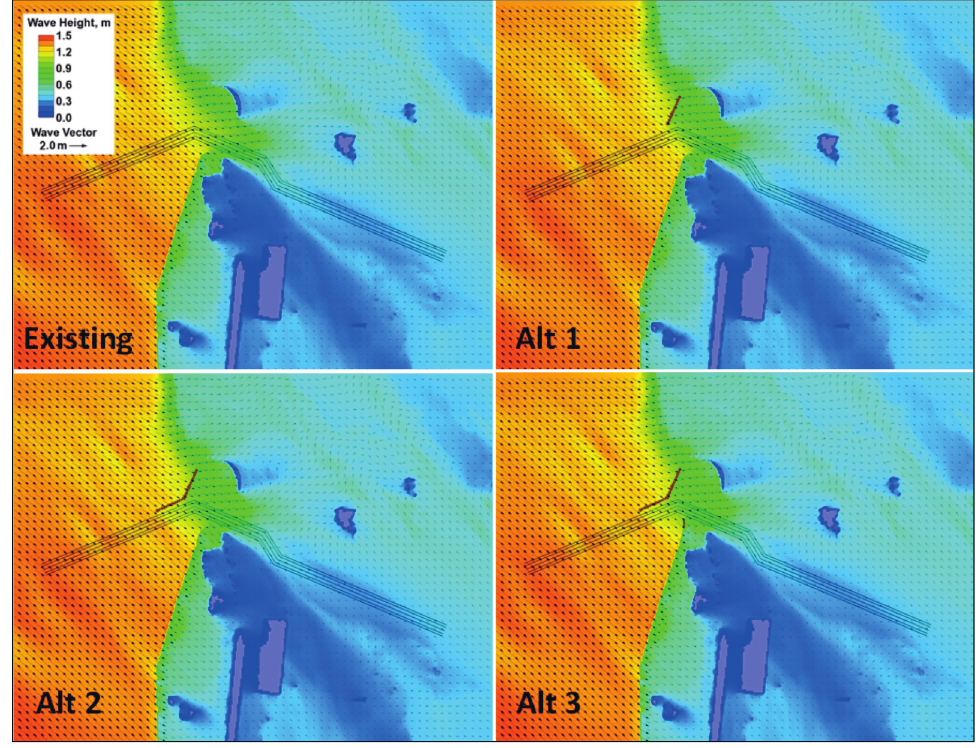
Figure 15. Example of model calculated wave heights in the west channel for the 50-year design winds from NW at 1.5 m water